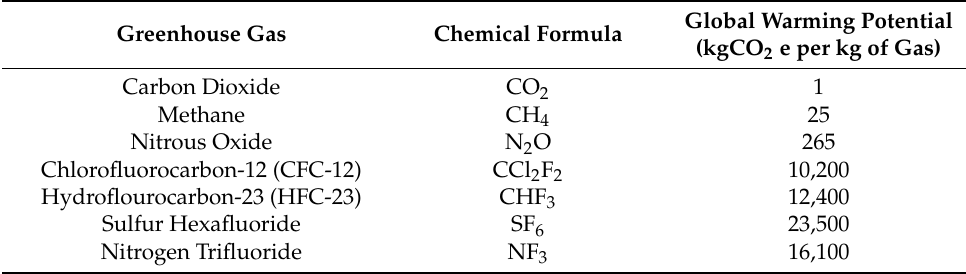
Table 1. Global Warming Potential for Major Greenhouse Gases